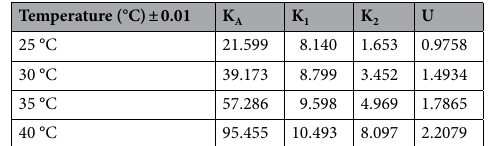
Temperature (°C) ± 0.01